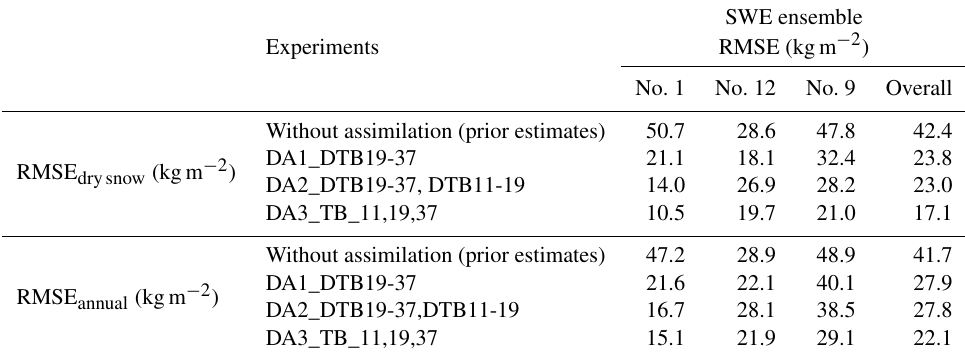
Table 5. Averaged SWE ensemble RMSE (see Eq. 11) obtained with and without DA, according to the experiment (see Sect. 3.4.3, Table 3 for acronyms) for each tested site. RMSE dry-snow is the SWE ensemble RMSE obtained from 1 December to 15 March. RMSE annual is estimated over the whole winter (when snowpack is detected). No. corresponds to the site (see Table 1). SWE